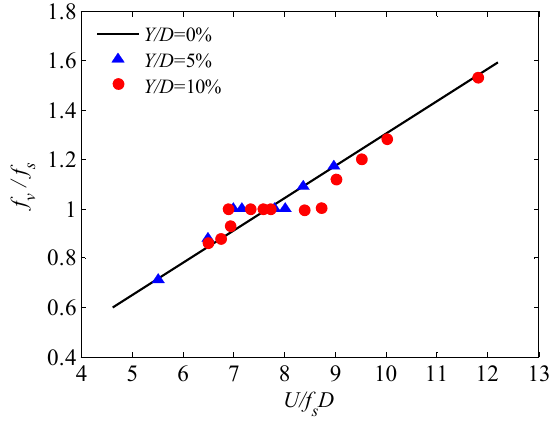
Figure 10. Lock-in phenomenon, after [29].